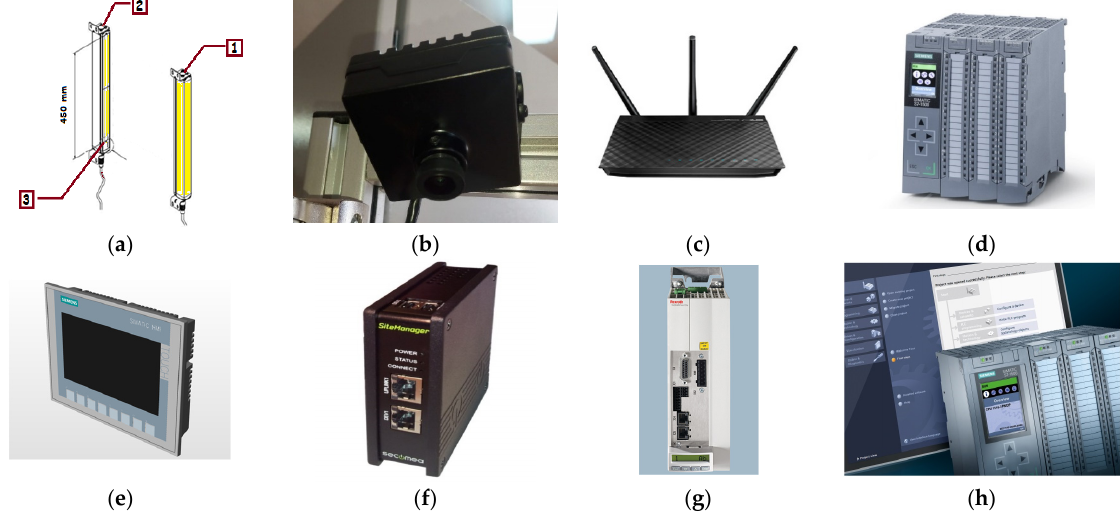
Figure 8. MMI4D components for safety and control. ( a ) Schematic representation of optical